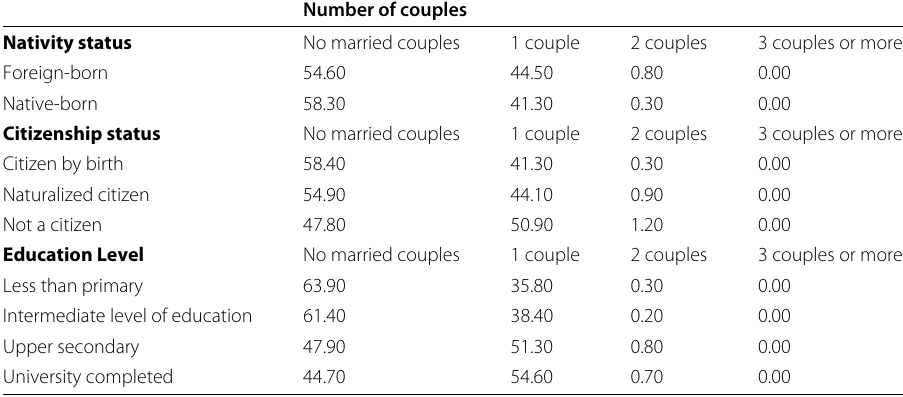
Table 18 Number of couples in the household by head-of-household characteristics (at least one old person)